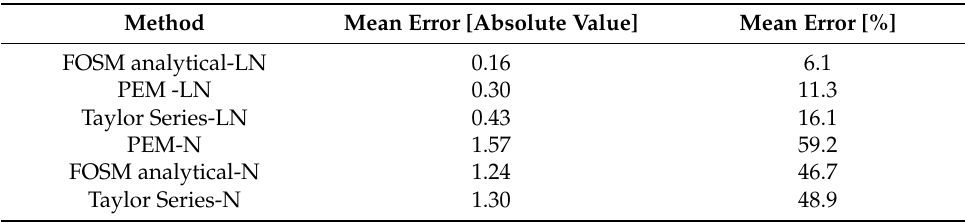
Table 7. Errors of FOSM analytical, Taylor Series and PEM methods.